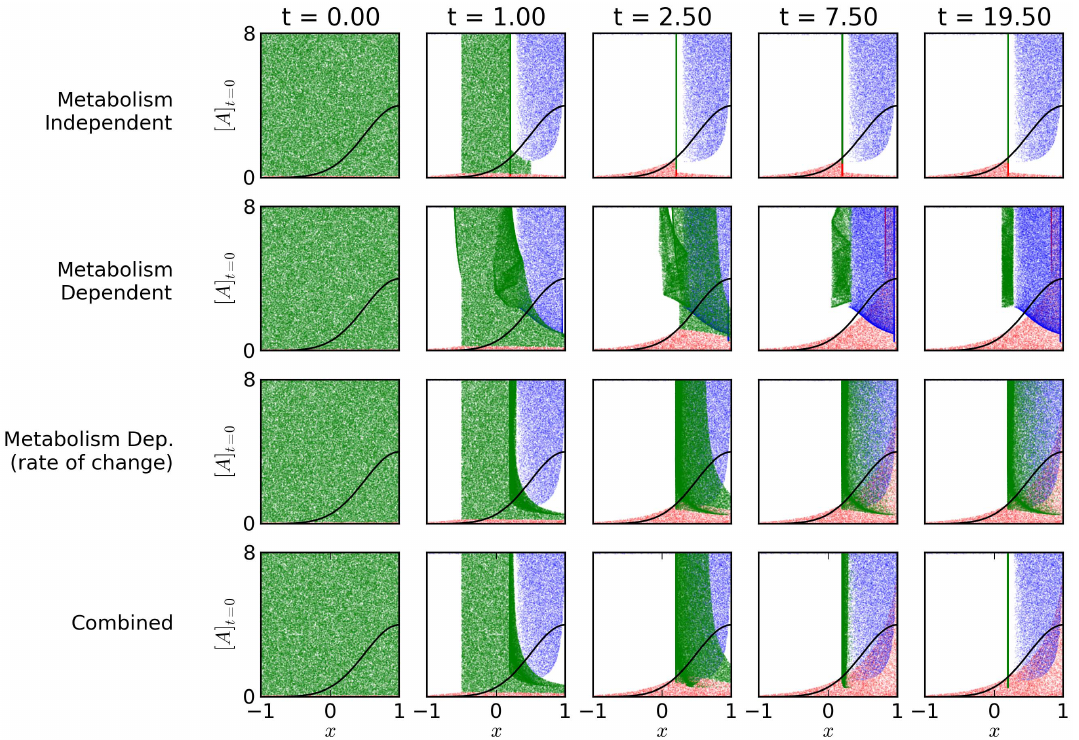
Figure 4. Spatio-temporal distributions of bacteria performing the four different behaviors. Spatial location ( x ) plotted against the initial . The distribution of ½ F (cid:2) in the environment is indicated by the black curve. Blue points indicate metabolic state of the simulated bacteria ½ A (cid:2) t ~ 0 bacteria that have died due to excess ( ½ A (cid:2) w 8 ), red points indicate bacteria that have died due to running low of autocatalyst ( ½ A (cid:2) v 0 : 1 ), and green points indicated bacteria that are alive ( 0 : 1 v ½ A (cid:2) v 8 : 0 ). The four behaviors produce qualitatively different spatio-temporal distributions.